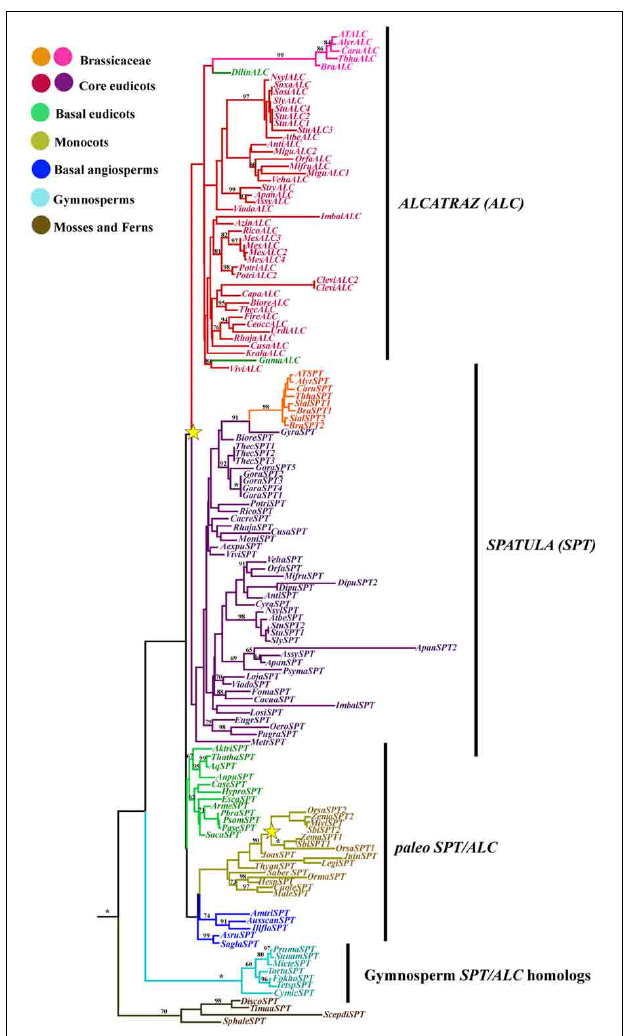
FIGURE 7 | ML tree of SPATULA/ALCATRAZ genes in seed plants showing two duplication events (yellow stars). One duplication in the Poaceae, resulting in two SPATULA-like clades, and a second independent duplication coincident with the diversification of the core eudicots resulting in the SPT and the ALC clades. Most sequence changes are linked with the ALC genes, particularly in Brassicaceae. Branch colors denote taxa as per color key at the top left; BS above 50% are placed at nodes; asterisks indicate BS of 100.